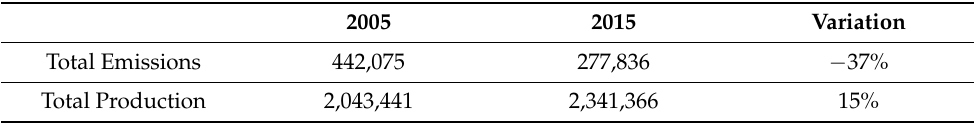
Table 2. Total production (millions of euros) and total equivalent CO 2 emissions (thousands of tons) in the period 2005–2015 and variations